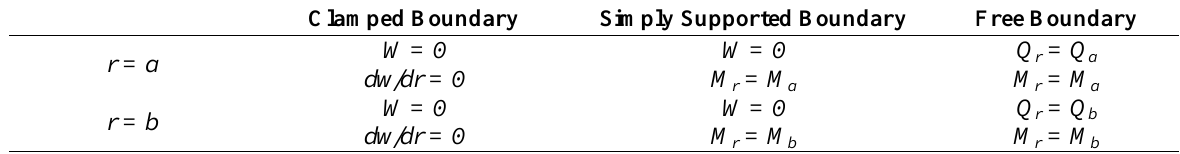
Table 1. Typical boundary conditions for annular plates Clamped